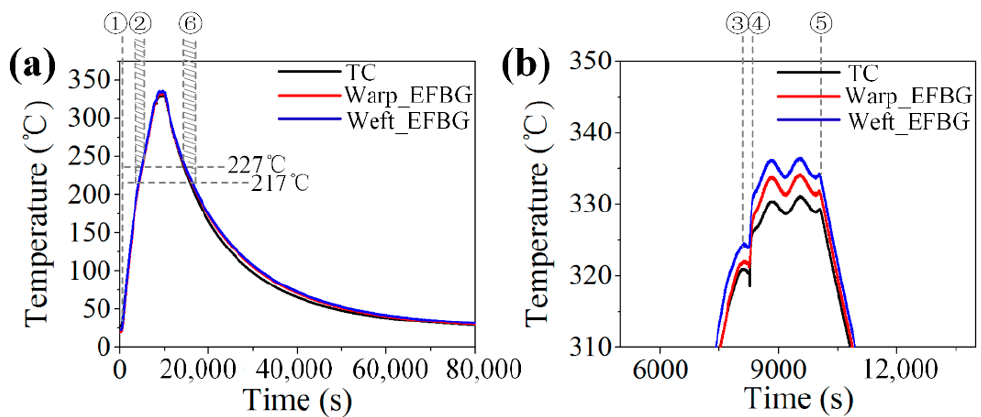
Figure 9. Reconstructed temperature cycles from EFBG: ( a ) entire temperature cycle and ( b ) enlarged view of the dwelling phase.